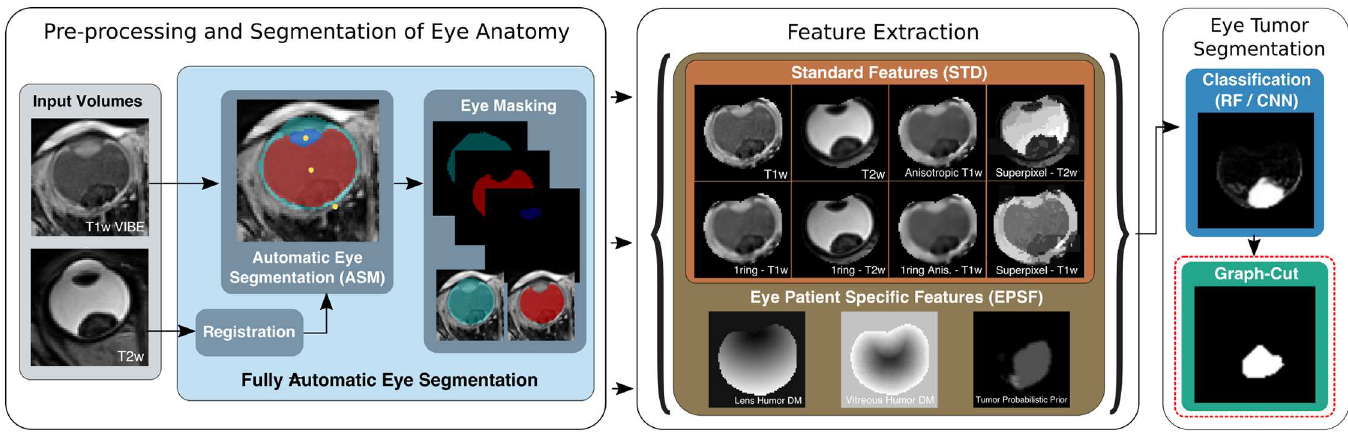
Fig 2. Proposed framework for automatic whole eye segmentation. T1w and T2w 3D volumes are combinedwith EPSF features. These features are used to train a RF / ConvolutionalNeural Network (CNN) classifier, servingas the data term in Graph-Cut